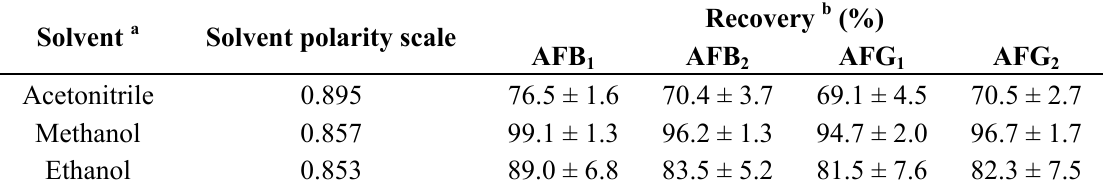
Table 1. Effect of different organic solvents on the recovery of